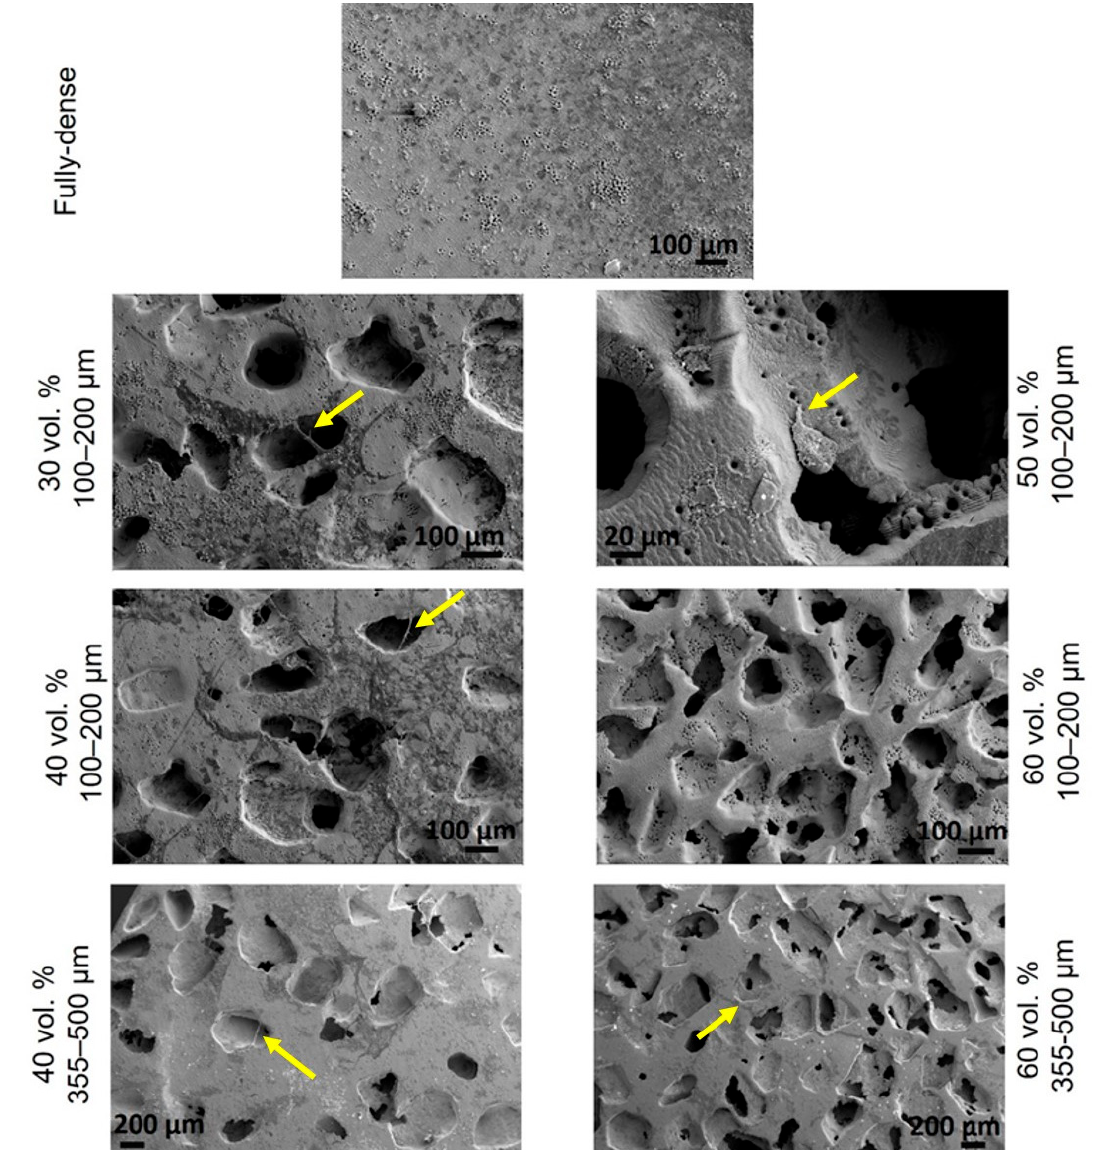
Figure 12. SEM images of the cell adherence of the fully-dense and porous substrates after femtosecond laser treatment. Cell–cell interactions and filopodium (yellow arrow) are indicated in the images.